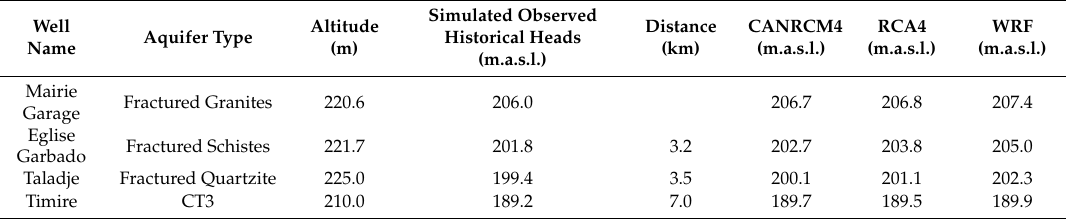
Table 2. Groundwater observation wells with the aquifer types, altitudes, distances between wells, and groundwater heads for the three